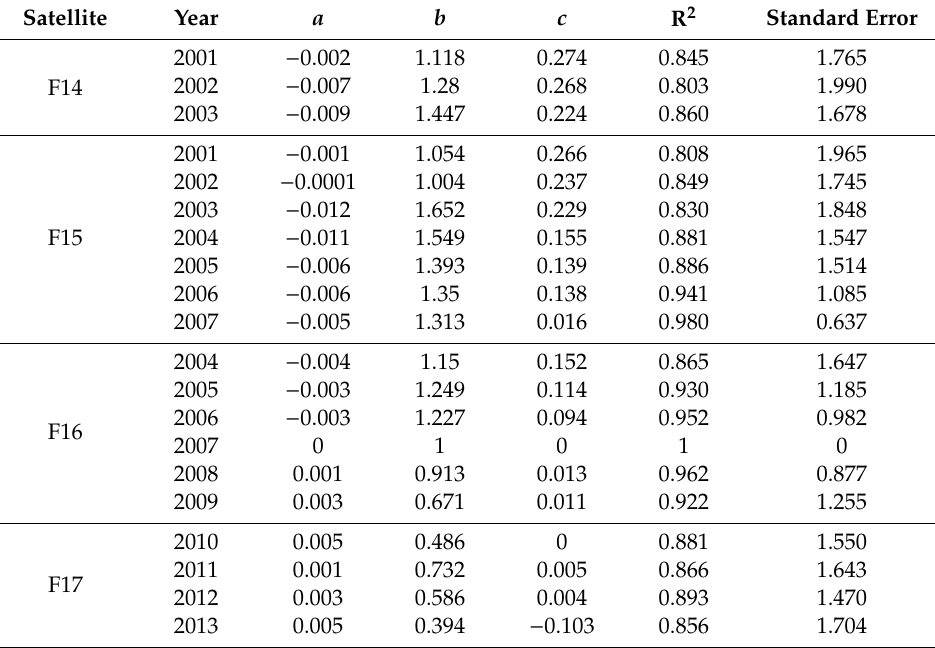
Table A2. Intercalibration model regression parameters of DMSP / OLS image